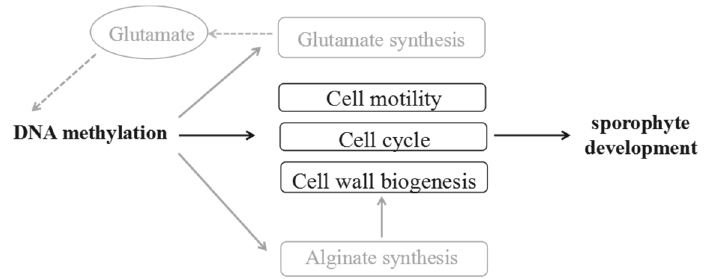
Figure 9. Summary of the effect of DNA methylation on sporophyte development. Supplementary Materials: The following are available online at https://www.mdpi.com/article/10.3390/ijms22189877/s1, Correlation Analysis between DNA Methylation and Gene Expression in Promoter Region. In total, we identified 60 promoter-associated DMR related genes, and randomly selected 26 genes for further transcript analysis. All genes exhibited obvious differential expression in “B vs. H” and “B vs. S” groups (Figure S7). However, negative correlations between the transcriptional abundances and DNA methylation levels were not obvious (Figure